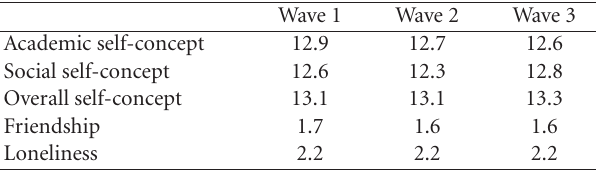
Table 1: Dependent variable mean